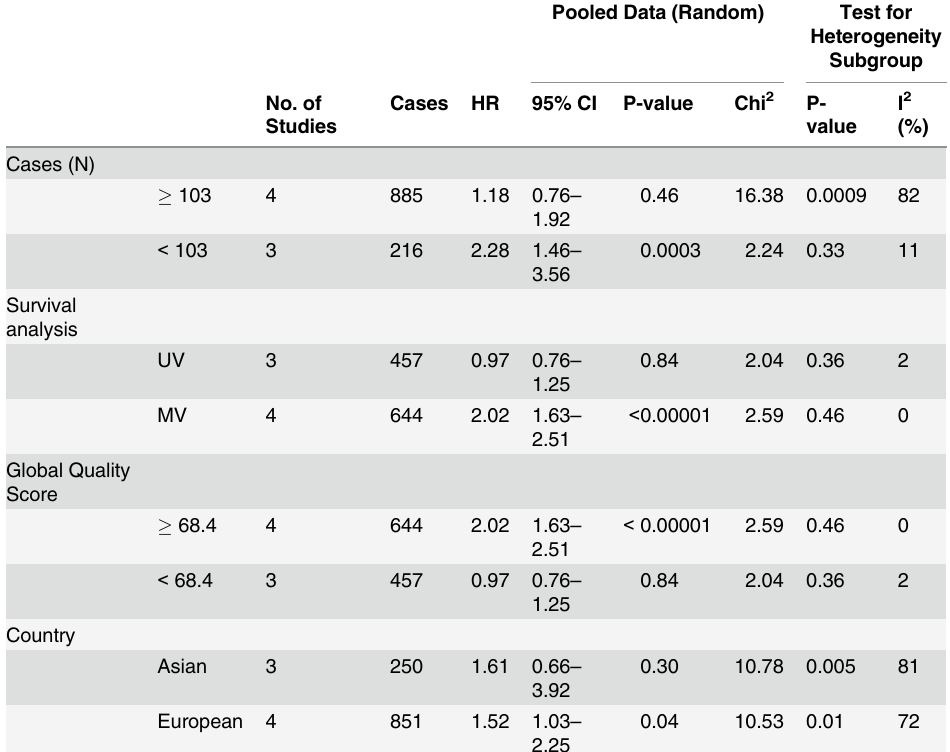
Table 3. Subgroup analyses evaluating methodological and demographic effects on the association between CXCR4 and overall survival in patients with